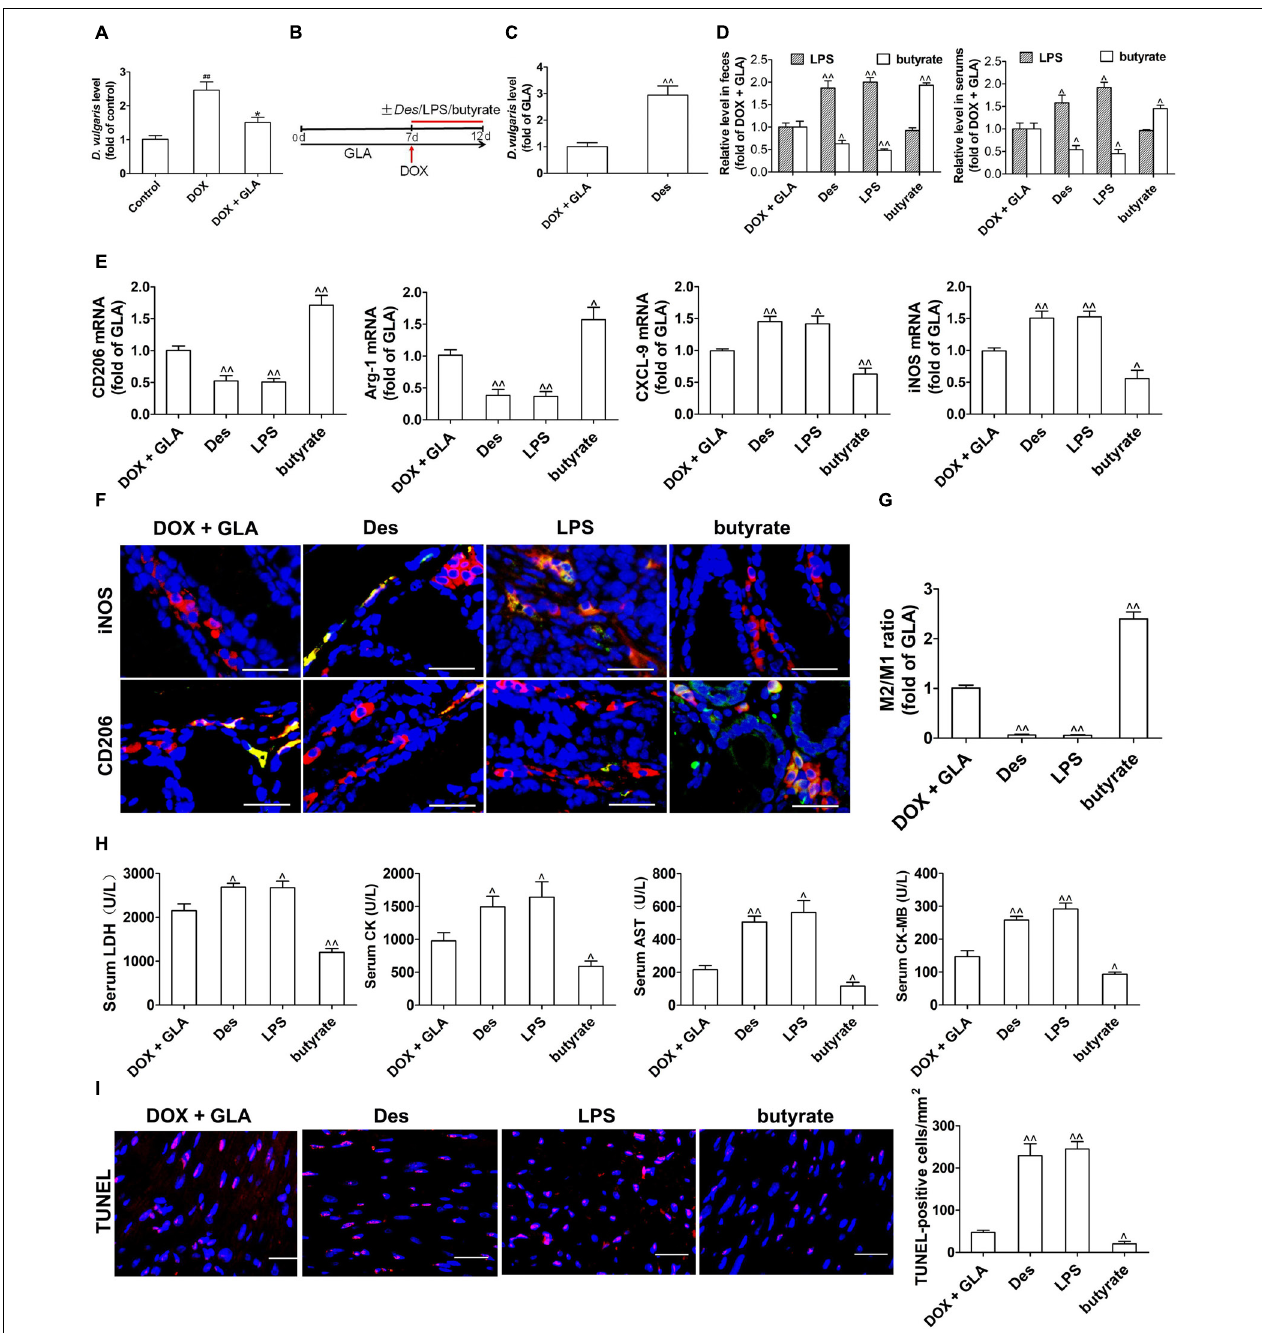
FIGURE 5 | Effect of gut microbiota and their products on cardiomyocyte apoptosis and colonic macrophage phenotypes in the doxorubicin (DOX)-treated mice. A single dose of DOX (20 mg/kg) was intraperitoneally injected into the C57BL/6 mice to induce acute cardiotoxicity. GLA (30 mg/kg) was intragastrically administered once daily for 12 days, starting 7 days before DOX injection. The mice from GLA (30 mg/kg) group were injected intraperitoneally with LPS (1 mg/kg), and orally administrated with sodium butyrate (1 g/kg) or Desulfovibrio vulgaris (Des) (1 × 10 9 CFU/mouse/every 2 days) 1 h after the injection of DOX. (A) The relative levels of D. vulgaris ( n = 10). (B) Schematic representation of the experimental approach. (C) The relative levels of D. vulgaris ( n = 10). (D) The levels of Lipopolysaccharide (LPS) and butyrate levels in feces and peripheral blood were determined by Limulus Amebocyte Lysate (LAL) assays or high performance liquid chromatography (HPLC), respectively ( n = 10). (E) Relative mRNA levels of M1 marker (iNOS and CXCL-9) and M2 markers (CD206 and arginase-1) in the colonic macrophage were measured by qPCR ( n = 10). (F) Immunostaining analysis of M1-like (CD68 + CD206 + ) or M1-like (CD68 + iNOS + ) macrophages in the colon was shown ( n = 10). Scale bars, 20 µ m. (G) Corresponding quantitative analysis of the ratio of M2-like/M1-like macrophages ( n = 10). (H) Serum levels of CK-MB AST, LDH, and CK were assessed ( n = 10). (I) Representative images of the TUNEL assay and quantitative result ( n = 10). Scale bars, 20 µ m. The values are presented as the mean ± SEM. # P < 0.05, ## P < 0.01 vs. control, ∗ P < 0.05, ∗∗ P < 0.01 vs. DOX, ˆ P < 0.05, ˆˆ P < 0.01 vs. DOX +